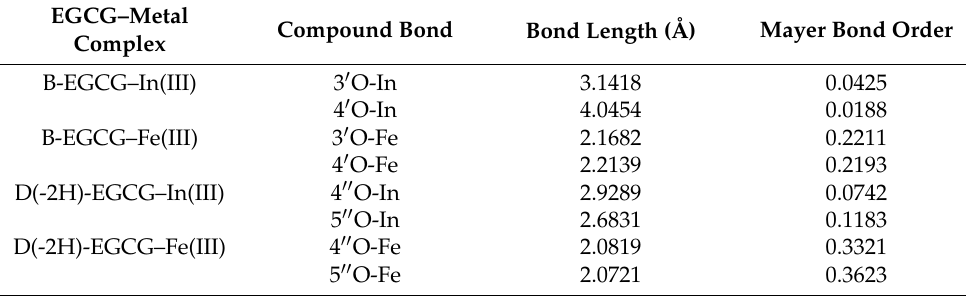
Table 1. Bond length and bond order of EGCG–metal